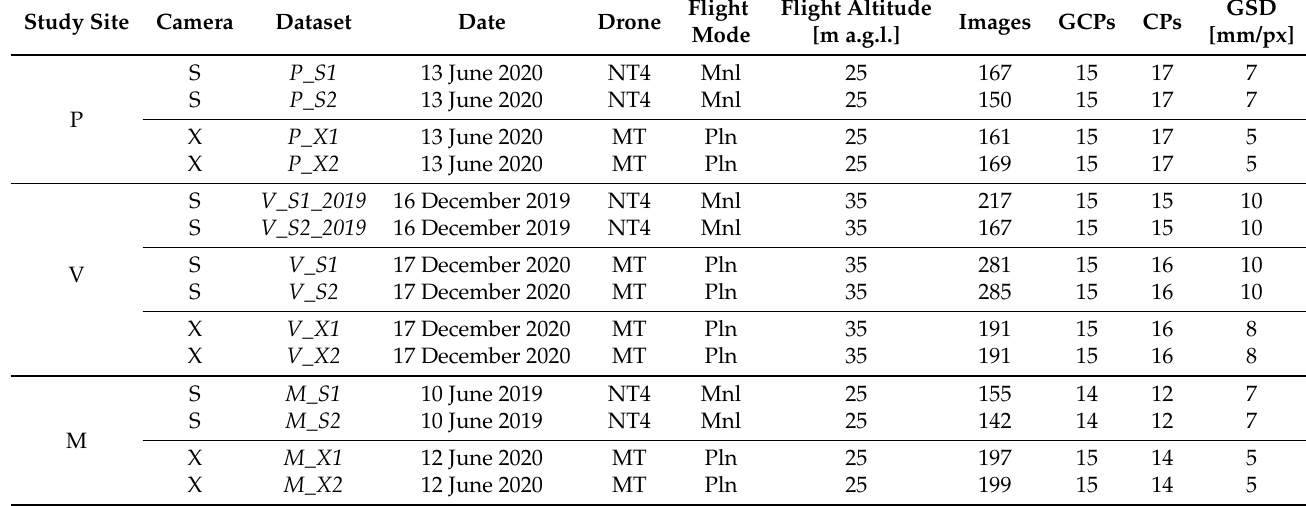
Table 2. Details of data acquisition. Study site: P = Palar; V = Vegliato; M = Moscardo. Camera: S = Sony α 5000; X = X5S. Drone: MT = Matrice, NT4 = NT-4C. Flight mode: Mnl = Manual, Pln = Planned. The last four columns report the number of acquired images (Images), the number of Ground Control Points (GCPs) used in the Bundle Adjustment process, the number of Control Points (CPs) considered for results evaluation purposes and the design Ground Sampling Distance (GSD),